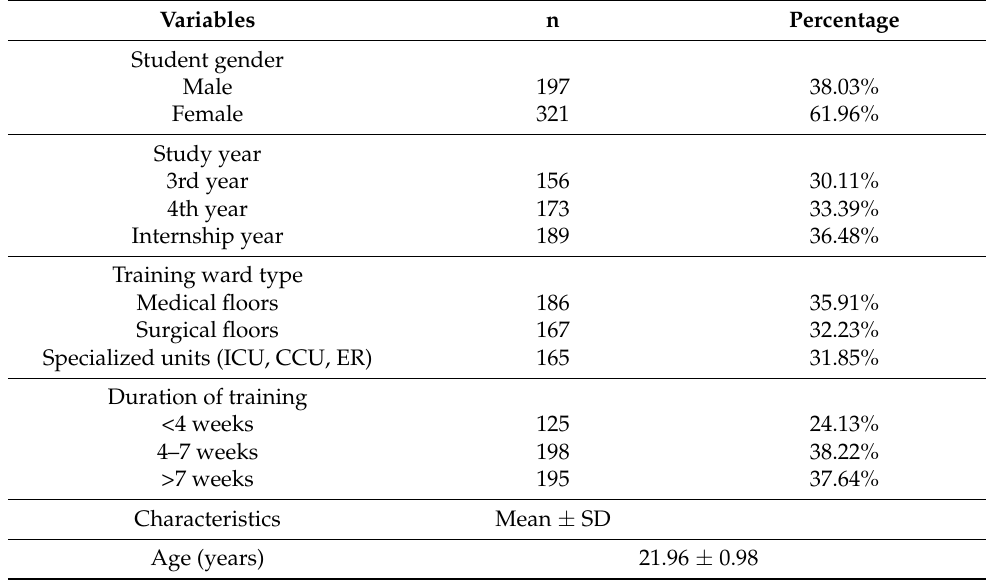
Table 1. Descriptive statistics of demographic factors (n =